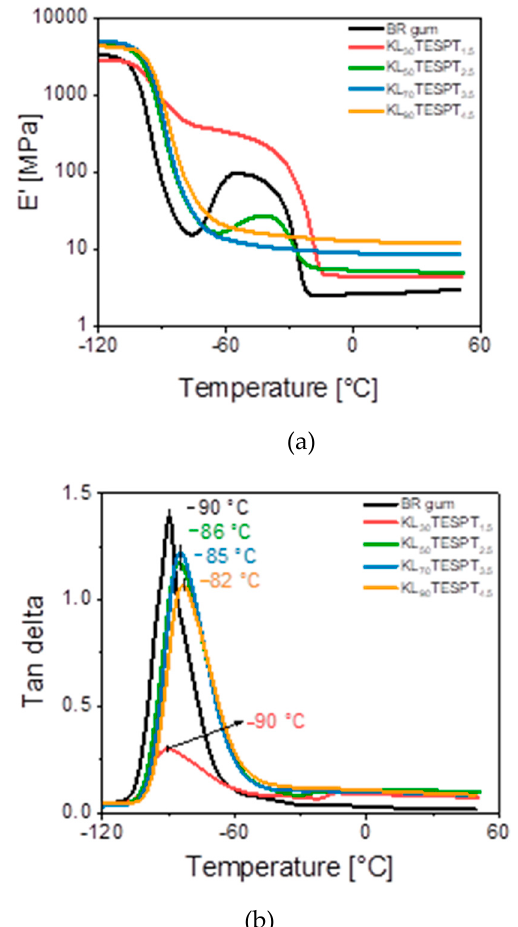
Figure 6. ( a ) Storage modulus as a function of temperature and ( b ) tan δ as a function of temperature (obtained from dynamic mechanical analysis) for BR gum and BR/kraft lignin (KL)/TESPT composites.